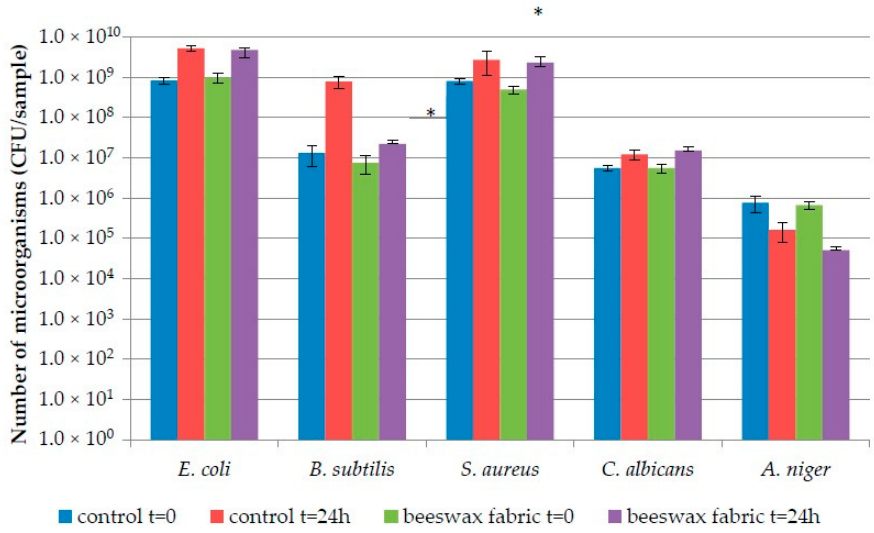
Figure 5. Number of microorganisms on Fabric 2. *—Statistically significant differences between number of microorganisms on control and beeswax-modified samples in the same time (one-way ANOVA, p < 0.05).